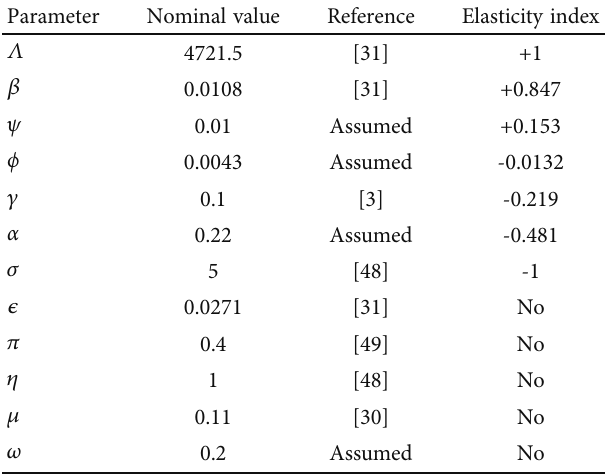
Table 2: Baseline values for model parameters of the model